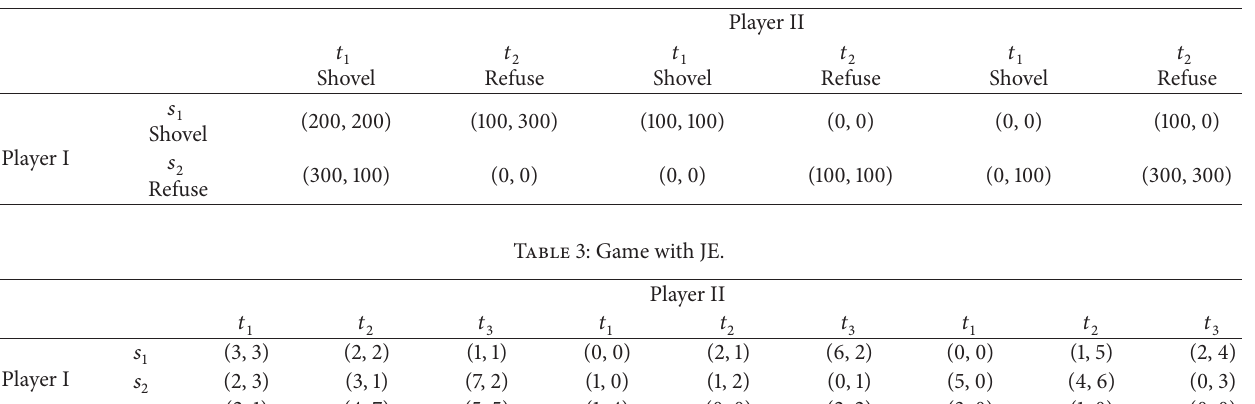
Table 2: Snow Drift game matrices.